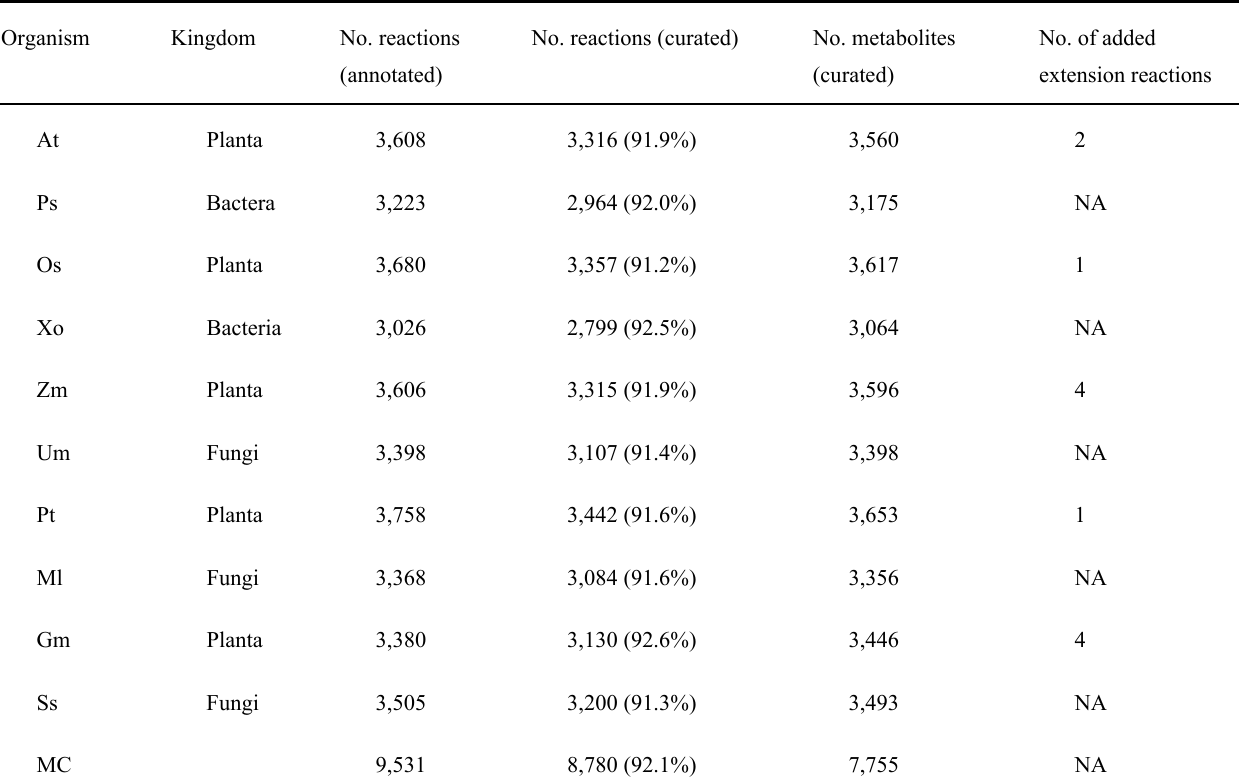
Table 3. Statistics of the number of reactions (annotated and after removing stoichiometrically inconsistent ones (‘curated’) and number of metabolites (connected to curated reactions) in all 10 organisms studied. The percentage values in the fourth column represent the percentage of curated reactions. In the final column, the numbers of reactions added to the plant networks during the gap filling process are denoted. This is not applicable (NA) to the pathogenic